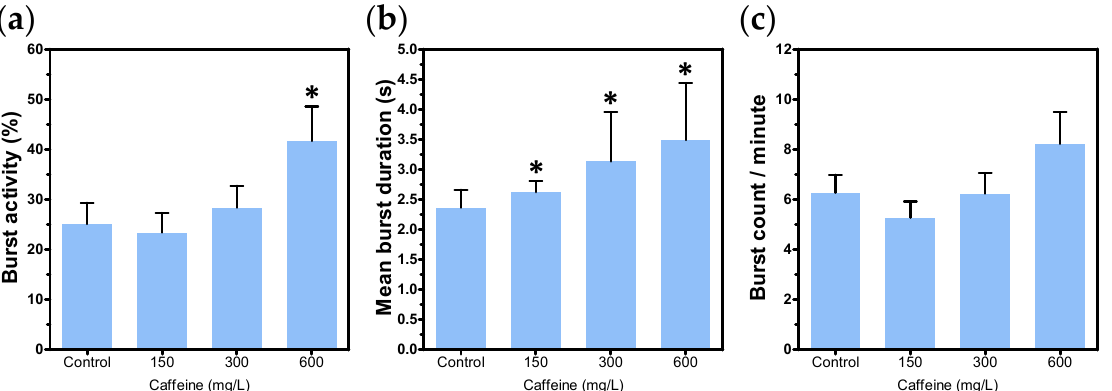
Figure 4. Coiling activity of zebrafish ( Danio rerio ) embryos aged 26.0–28.5 hours post-fertilization (hpf) following exposure to a positive control candidate for hyperactivity. ( a ) Percentage (%) of burst activity; ( b ) mean burst duration (seconds); ( c ) burst count per minute. Significant differences between control (embryo medium) and treatments were tested by ANOVA on ranks (Kruskal–Wallis test) followed by the Dunn’s post-hoc test (* p ≤ 0.05); n = 60 embryos per treatment, divided into three independent experiments. Values are expressed as means (bars) and 95% confidence intervals (error bars).